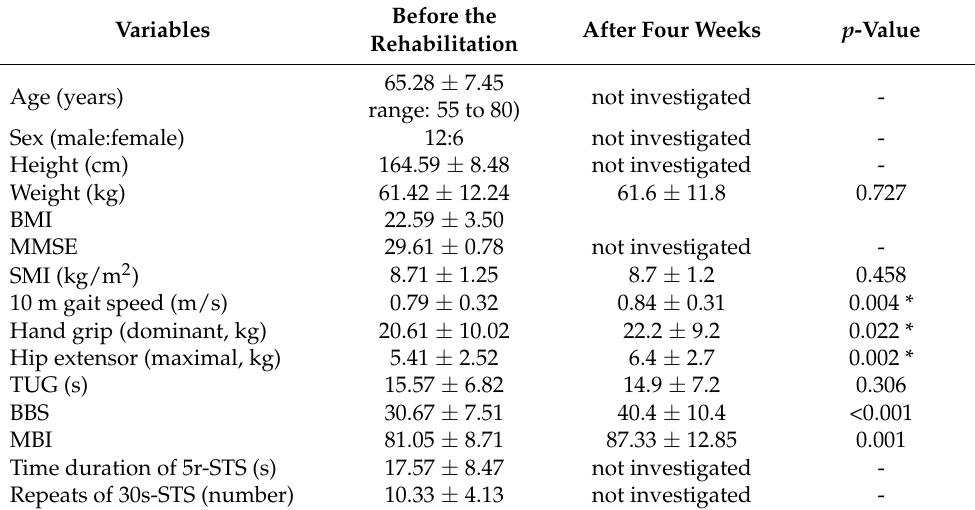
Table 1. Baseline and follow-up data for patients with HAD. Before the Variables After Four Weeks p Rehabilitation